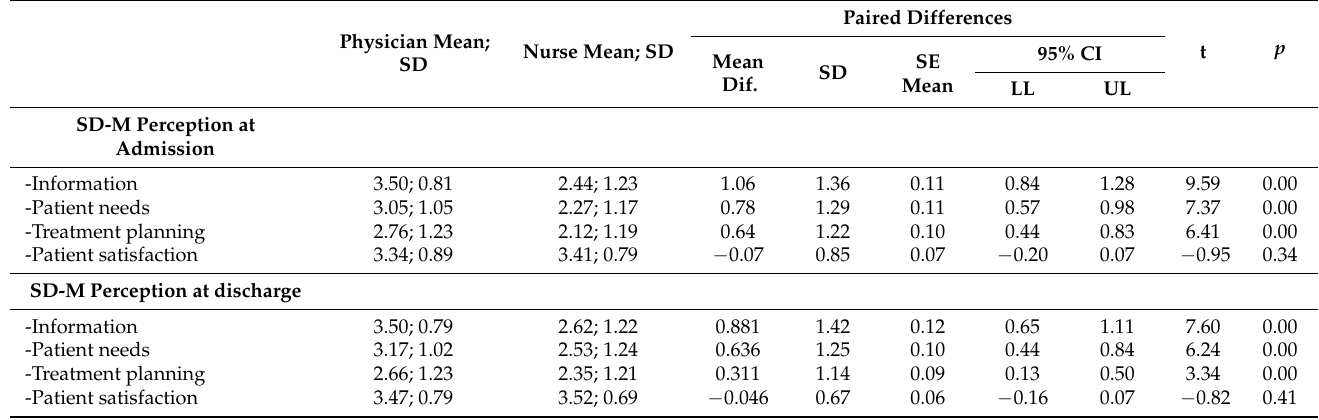
Table 2. Paired sample test comparing patients’ scores with referring to nurses and physicians.